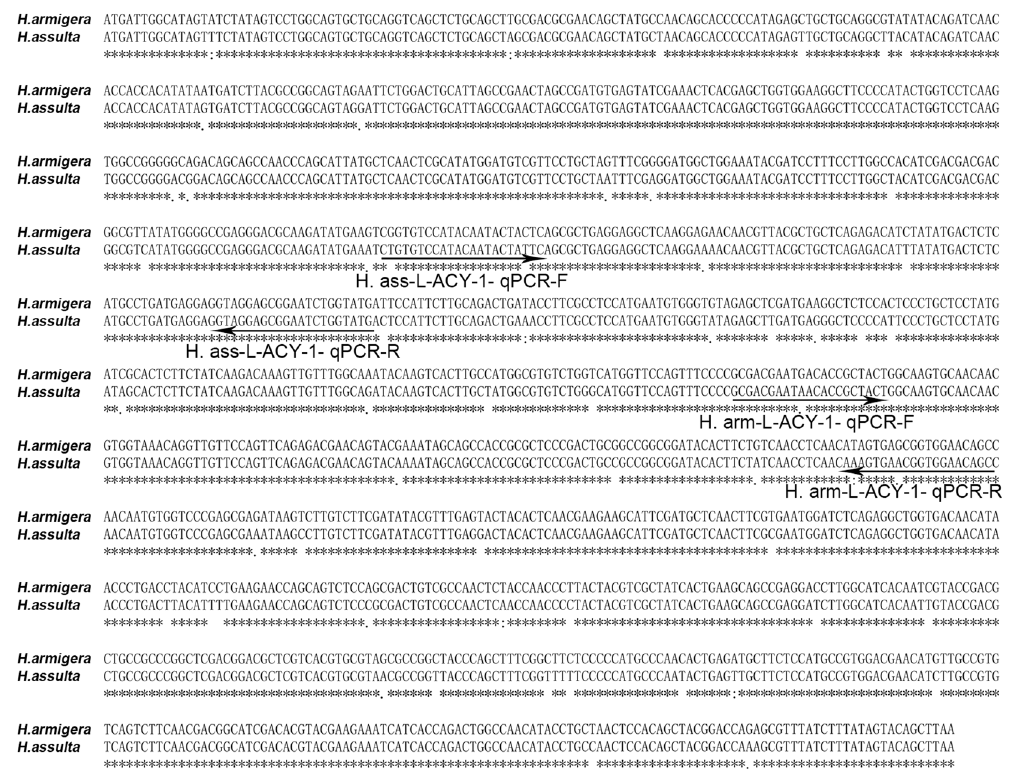
Figure 7. Nucleotide alignment of H. armigera and H. assulta L-ACY-1 gene. The annealing positions of the two primer pairs used for qRT-PCR analysis of L-ACY-1 in either species are depicted with arrowed lines and the corresponding primer